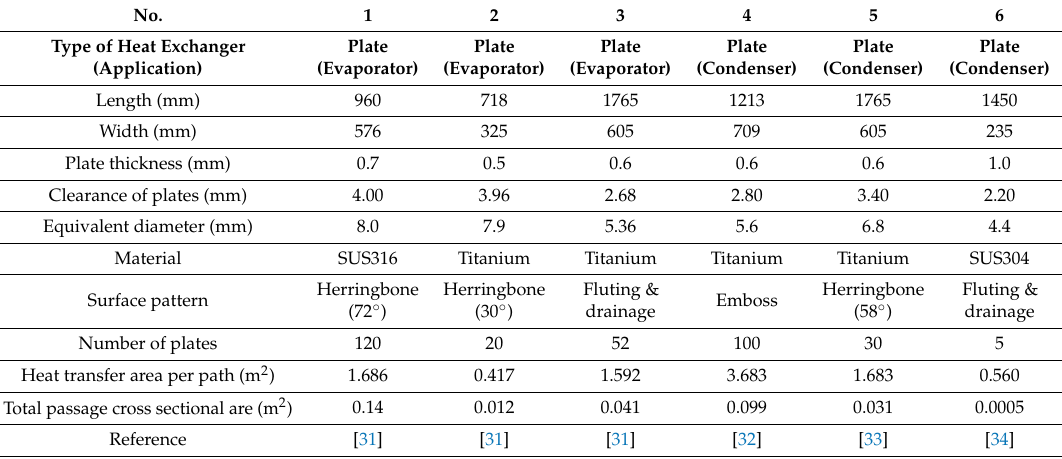
Table 1. Heat exchanger